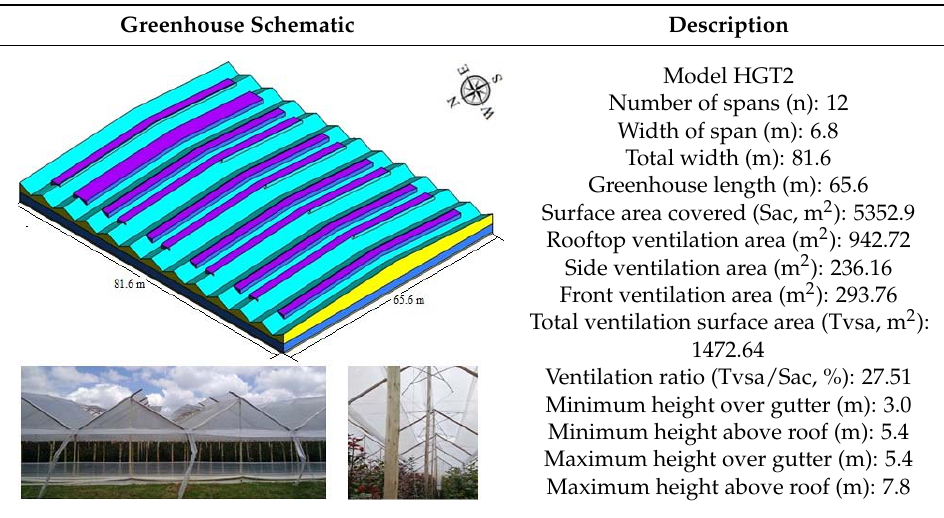
Table 4. General characteristics of the HGT2 greenhouse.